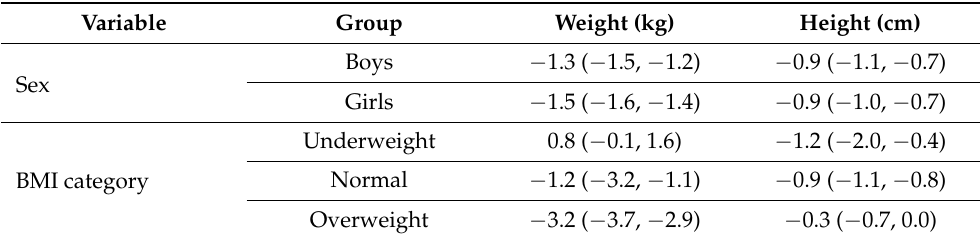
Table 3. Mean differences (95% CI) between self-reported and measured weight and height in difference population